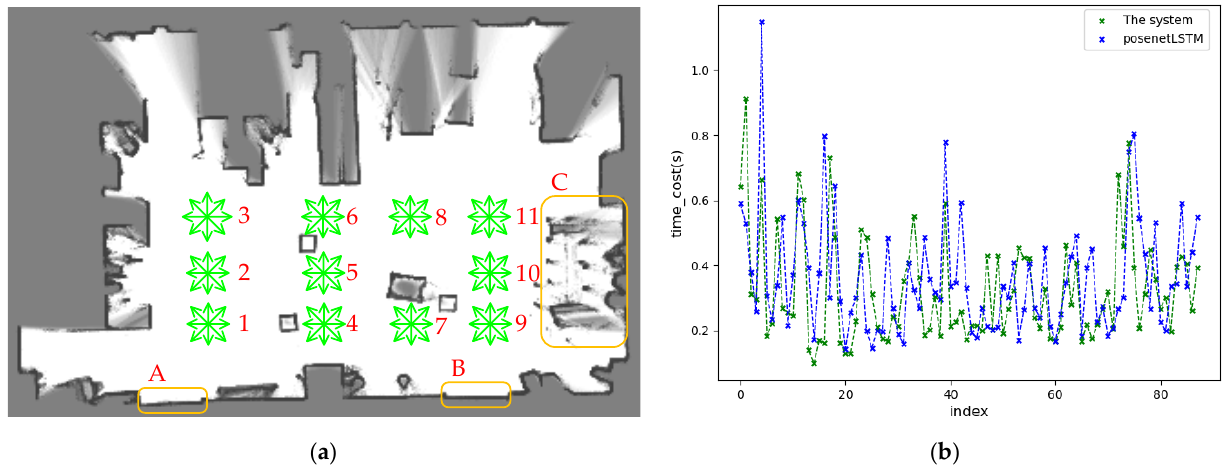
Figure 18. ( a ) Location of 11 test points; ( b ) Search time from coarse to fine pose. The test results show the system’s excellent precision relocation capabilities. For example, in test positions 1 and 9 facing the door, the image information obtained by the camera was very similar, and position 9 also contained chaotic environmental parts. The position of the two doors and the chaotic part are shown as A, B, and C in Figure 18a. However, the algorithms can successfully complete precise relocation, showing excellent precise relocation capabilities and the relocation process is shown in Figure 19.